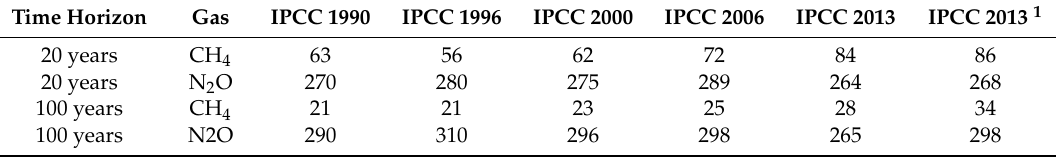
Table 1. Global Warming Potential (GWP) values since the first assessment report, unitless